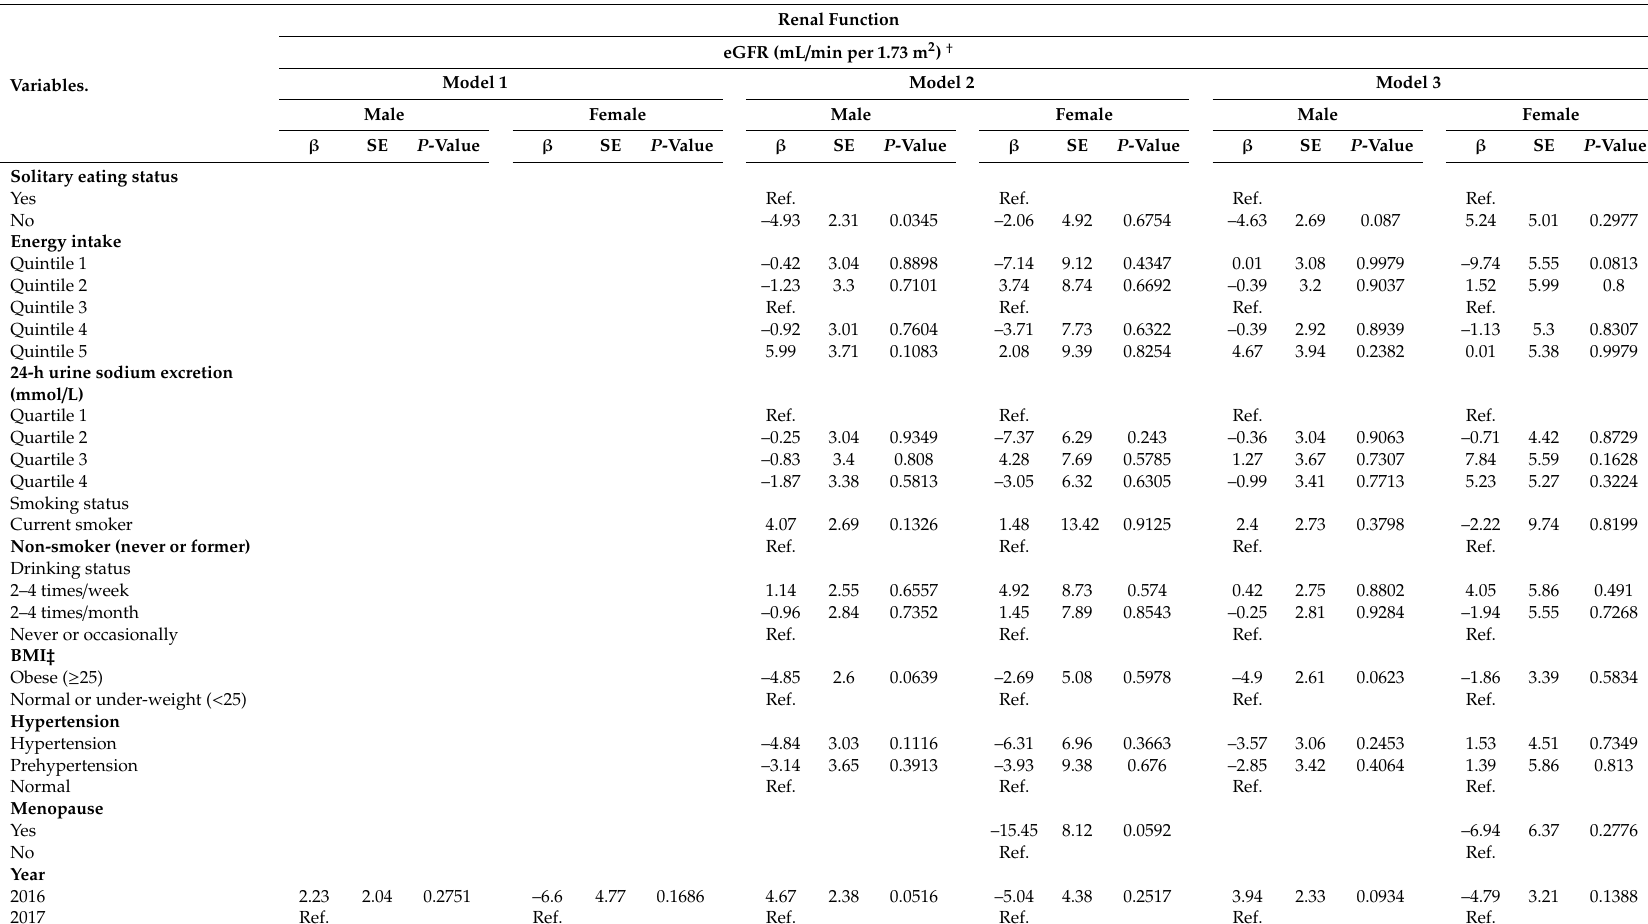
Model 1: Odds ratio after controlling for duration of diabetes, diabetes treatment status, sociodemographic variables, and economic variables; Model 2: Odds ratio after controlling for duration of diabetes, diabetes treatment status, health-related variables, and nutrition-related variables; Model 3: Odds ratio after controlling for all variables included in the study; BMI, body mass index; † Modification of Diet in Renal Disease estimated glomerular filtration rate (mL / min per 1.73 m 2 ); eGFR = 175 × (SCr) –1.154 × (age) –0.203 × 0.742 (if female); ‡ Obesity status defined by BMI based on 2014 Clinical Practice Guidelines for Overweight and Obesity in